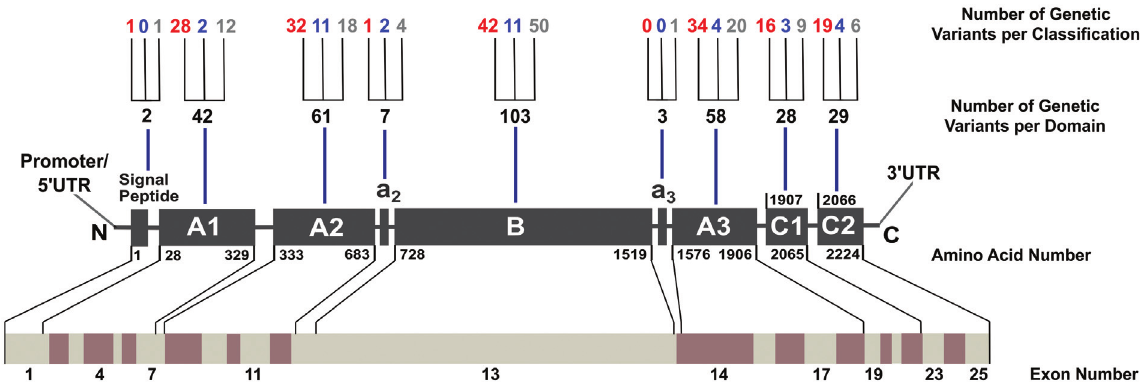
Fig. 1 Distribution of the 363 unique variants identi fi ed within the F5 gene and FV protein. The FV protein is comprised of the A1-A2-a2-B-a3-A3-C1- C2 domains and linkers in that order, and is shown as gray boxes that are not drawn to scale. N and C represent the N- and C-termini, respectively. Residue numbering marks the fi rst and last amino acids which frame each domain, reported in HGVS format (starting with 1 at the signal peptide). The number of variants in each domain is shown above each protein domain. The number of variants associated with FV de fi ciency ( red ), thrombosis or FV Leiden ( blue ), or have an unknown association ( gray ) are indicated. Intronic variants (19 in total), unde fi ned or not applicable variants (nine), and variants affecting multiple domains (two) are not shown. Below the protein domains, the gene arrangementof 25 exons is shown as alternating light gray and maroon boxes drawn to scale. The FV protein domain to which each exon codes for are indicated. FV, Factor